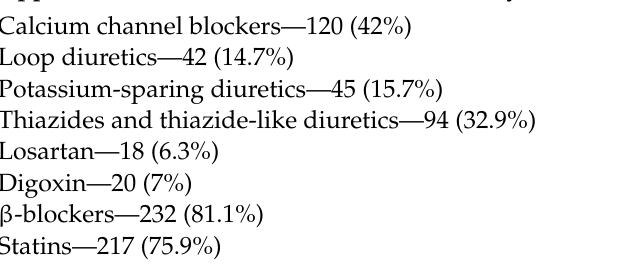
tary results. Table S1. Mobile phase composition in chromatographic separation; Table S2. Flow rates in chromatographic separation; Table S3 Oligonucleotide probes immobilized on a biochip; Table S4. Primers for amplification of rs71647871 and rs2244613 for biochip analysis; Table S5. Baseline